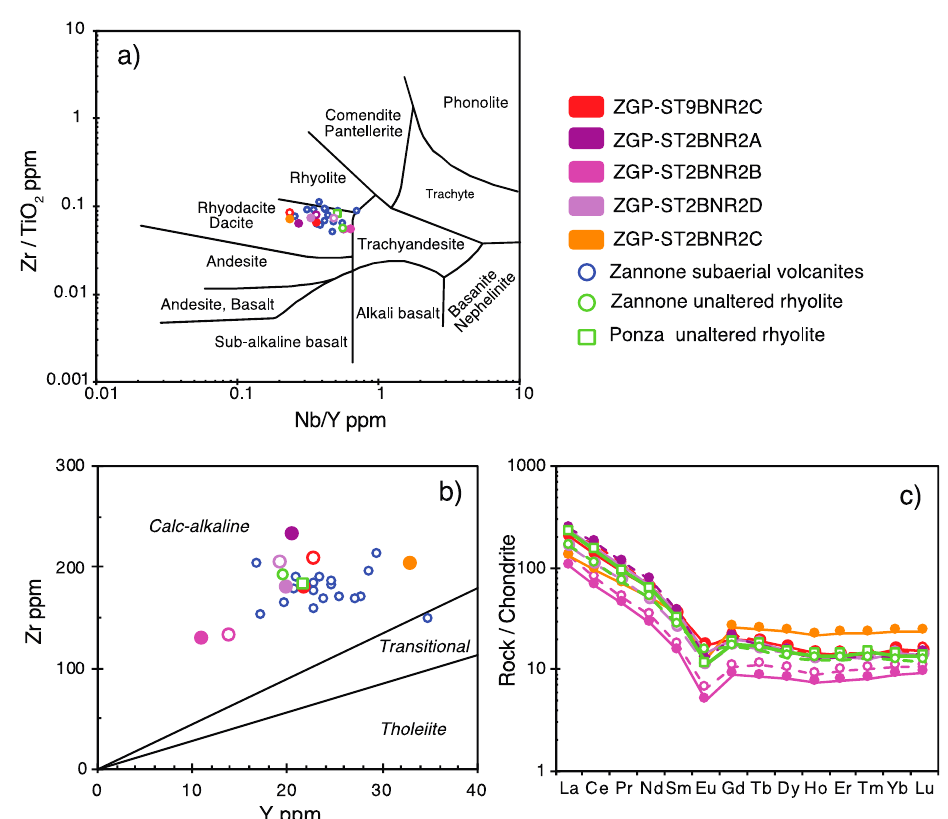
Figure 13. ( a ) Nb/Y vs, Zr/TiO 2 discrimination diagram for rock classification from [31]. ( b ) Zr-Y diagram for discriminating magma affinity from [33]. ( c ) Rare earth element (REE) patterns normalized to chondrite C1 [32] of the ZGP clasts. Zannone subaerial volcanites are from Conte and Dolfi [26]. Data of unaltered Zannone and Ponza volcanics are from Conte et al. [28]. Symbols ZGP clasts: full—inner portion, empty—outer portion.